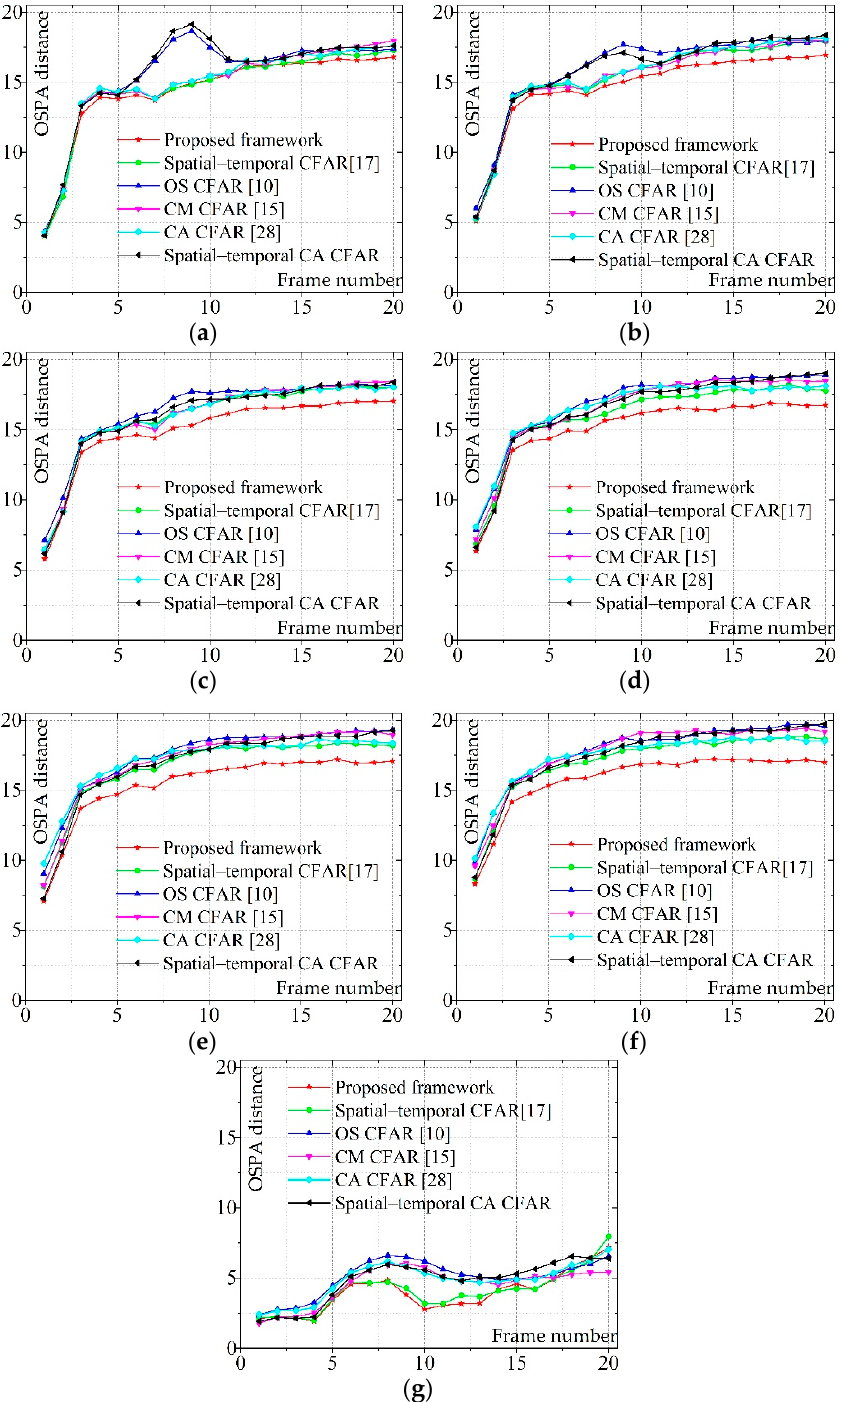
Figure 9. The OSPA distance of six scenarios at each scan: ( a – f ) Groups 1–7; and ( g ) Group